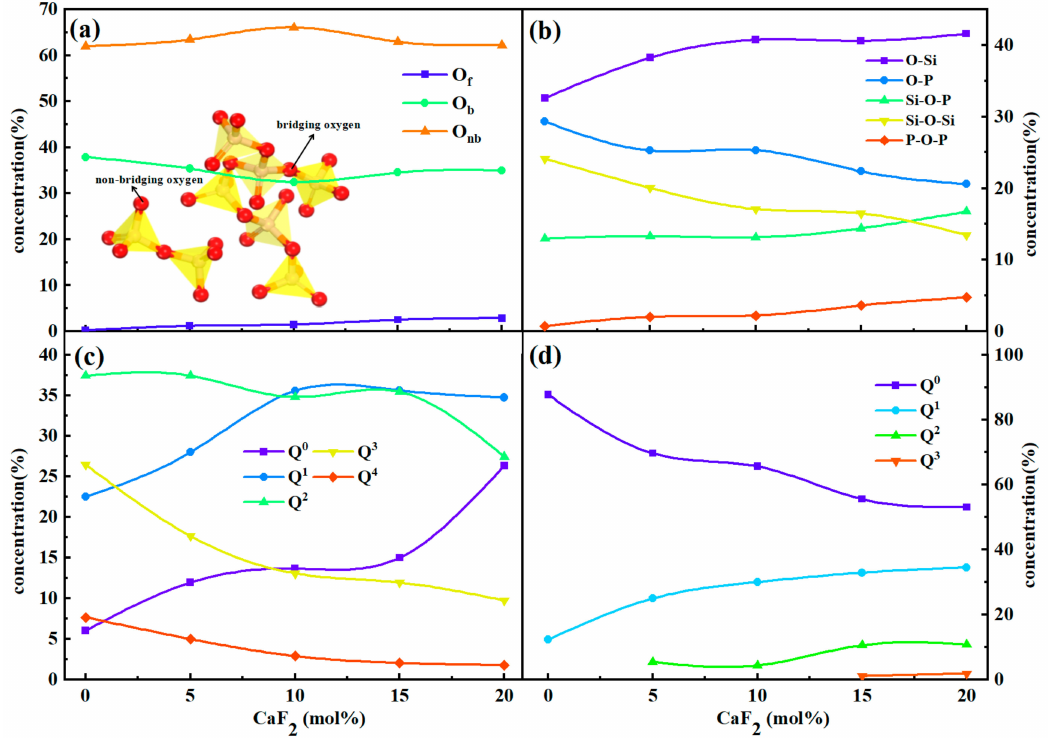
Figure 5. Structural unit evolution. ( a ) Types of oxygen atoms and ( b ) types of oxygen atoms after subdivision. ( c , d ) Distribution of Q n with different CaF 2 contents: ( a ) Q n Si and ( b ) Q n